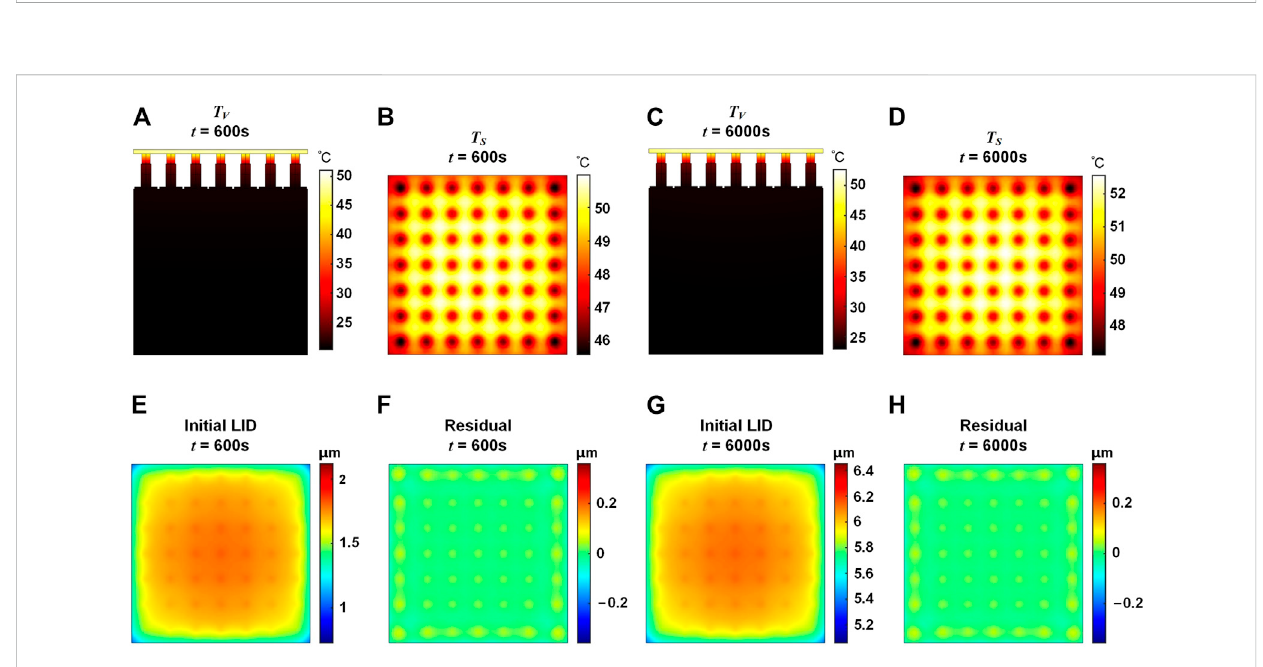
FIGURE 4 Temperature distribution and LID of the DDM under 600 s and 6000 s laser irradiation. (A) Overall temperature distribution T V , t = 600 s. (B) Mirror temperature distribution T S , t = 600 s (C) T V , t = 6000 s (D) T S , t = 6000 s. (E) Initial LID, t = 600 s. (F) Self-correction residual, t = 600 s. (G) Initial LID, t = 6000 s. (H) Self-correction residual, t = 6000